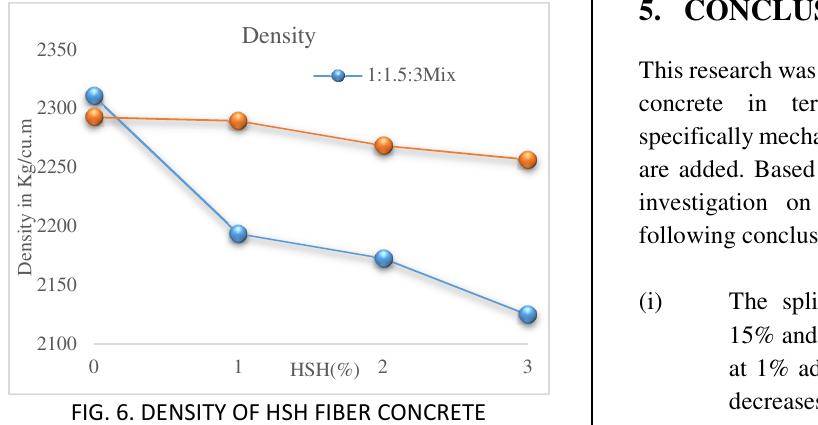
FIG. 6. DENSITY OF HSH FIBER